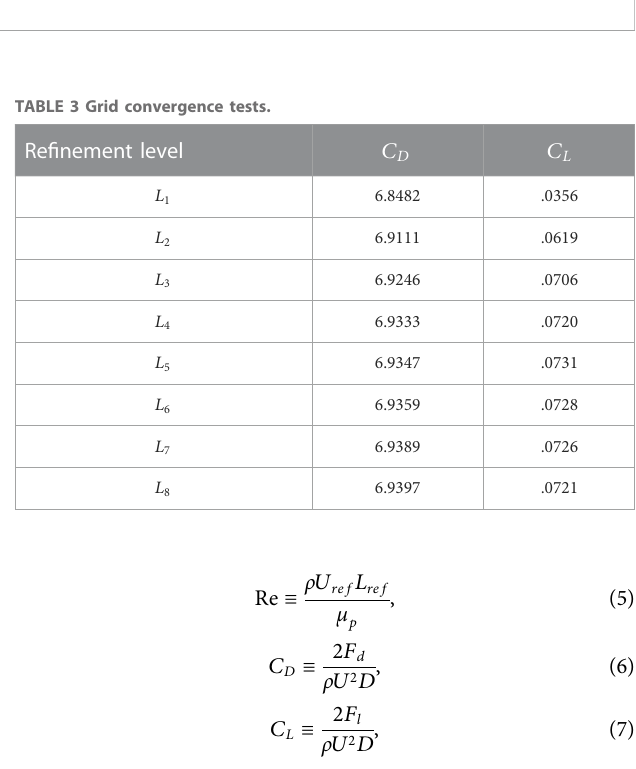
FIGURE 3 Sequence of grids on the space mesh level: 1, 2, and 3 (from left to right).